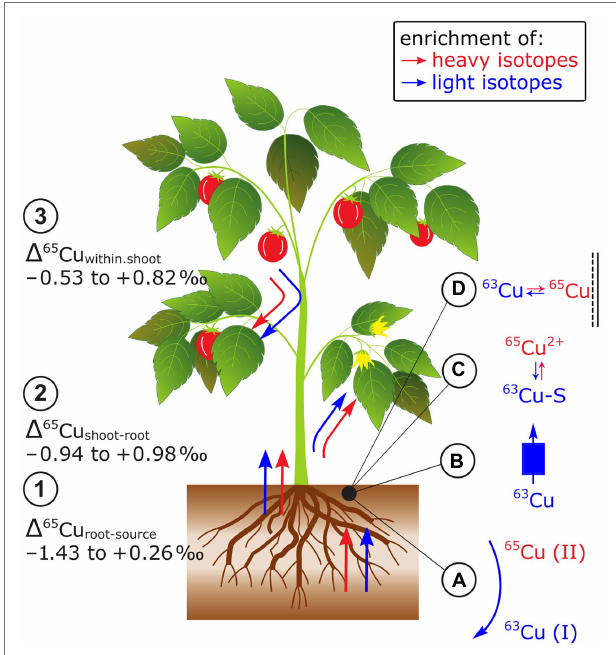
FIGURE 8 | Cu isotope fractionation in plants exemplified for tomato plants. (1) Root uptake can lead to an enrichment of heavy or light Cu isotopes. The isotope fractionation during root uptake is more negative in Fe strategy I plants compared to strategy II plants. At low Cu supply light isotopes were preferentially taken up compared to heavy isotopes at high supply likely due to a shift from active to passive uptake. (2) Shoots can be enriched in light and heavy isotopes compared to roots. The enrichment of light isotopes increases with organ height and Cu availability. (3) Cu isotopes fractionate in shoots of Fe strategy I plants is stronger than in strategy II plants. (A) Cu reduction induced by root reductases favors light Cu isotopes, (B) Cu membrane transport can favor light Cu isotopes, and (C) Cu binding to S to detoxify Cu in the root at high Cu supply may contribute to the retention of light isotopes in roots. (D) Cu binding to O ligands in the root apoplast should retain heavy Cu in the